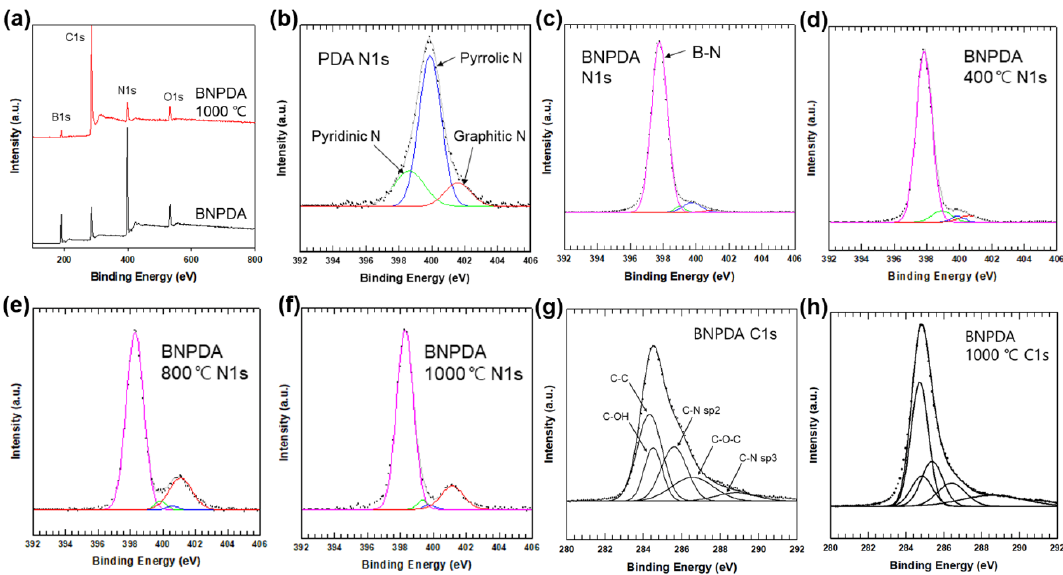
Figure 4. ( a ) XPS survey spectra of BNPDA and BNPDA-1000. N1s XPS spectra of ( b ) PDA, ( c )